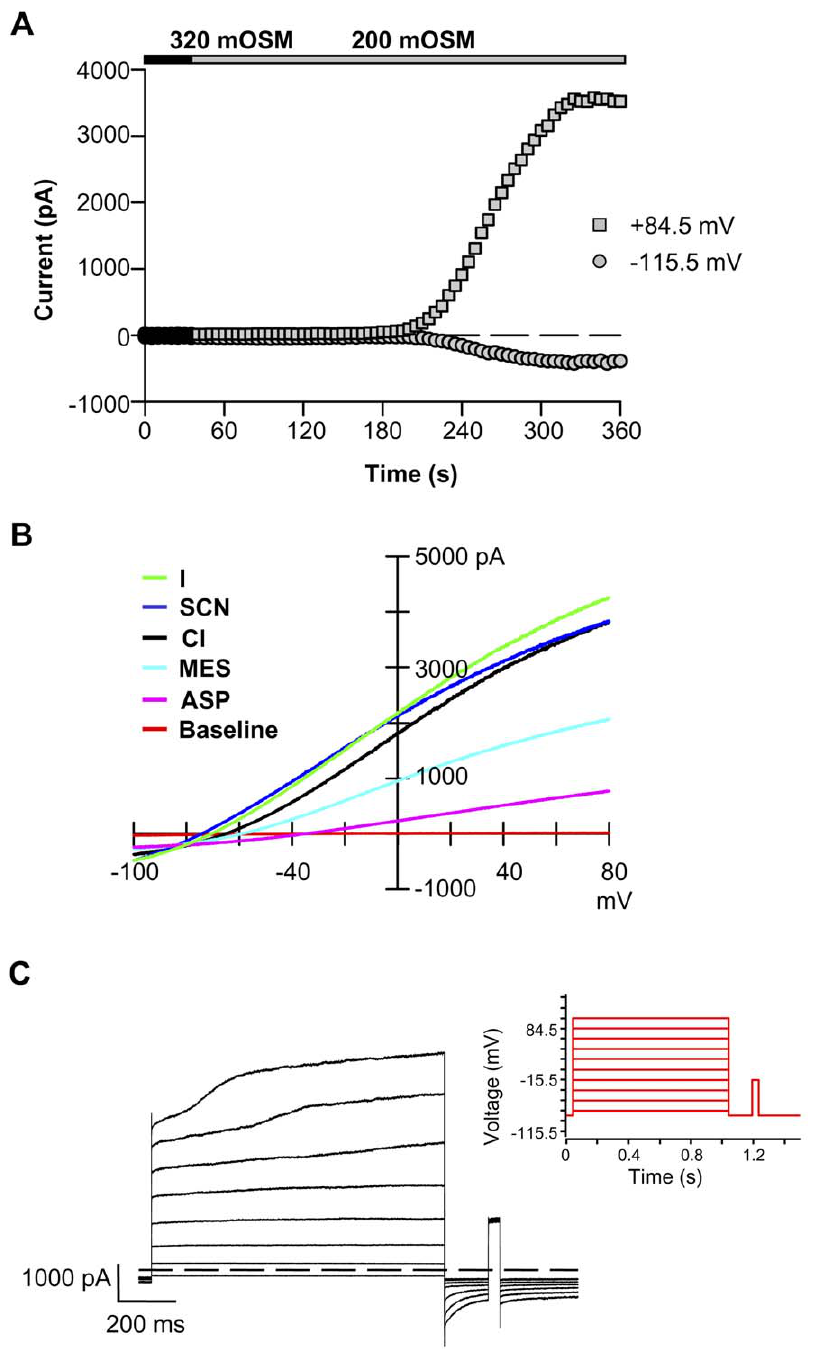
Figure 1. Characterization of the S2R + cell I Clswell . ( A ) Hypo-osmotic solutions slowly activate I Clswell . I Clswell begins to activate 1.7 6 0.3 min after exposure to 200 mOSM solution and reaches steady state activation within 5 6 0.3 min (n=13). I Clswell was assessed in ramp protocols and reported at + 84.5 mV (upper trace) and -115.5 mV (lower trace). 240 mOSM stimulates I Clswell activation slightly more slowly (1.8 6 0.3 min to initiation and 5.2 6 0.6 min to steady state, n=12; data not shown). ( B ) The S2R + cell I Clswell is anion-selective. I Clswell was activated by 200 mOSM solution; relative permeability and slope conductance sequences were determined for the steady state I Clswell by replacing Cl 2 with equimolar anion concentrations. ( C ) An extended step protocol (red inset) reveals more than one set of activation kinetics with offset activation initiation times.